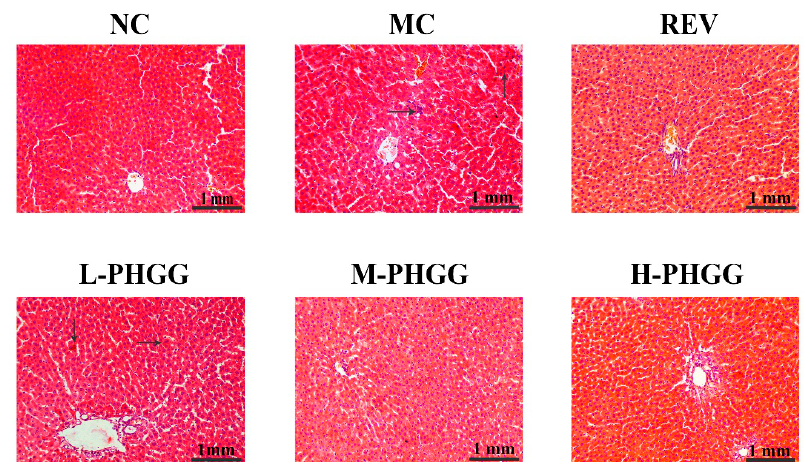
Figure 1. Effects of partially hydrolyzed guar gum (PHGG) on histopathological changes in the liver of rats. (Hematoxylin and eosin staining, 200×). The hepatocytes fit morphological criteria of apoptosis labeled by arrows. NC, normal control (saline); MC, D -gal model control (saline); REV, resveratrol (20 mg/kg/day); L-PHGG, 500 mg/kg/day; M-PHGG, 1000 mg/kg/day; H-PHGG, 1500 mg/kg/day.